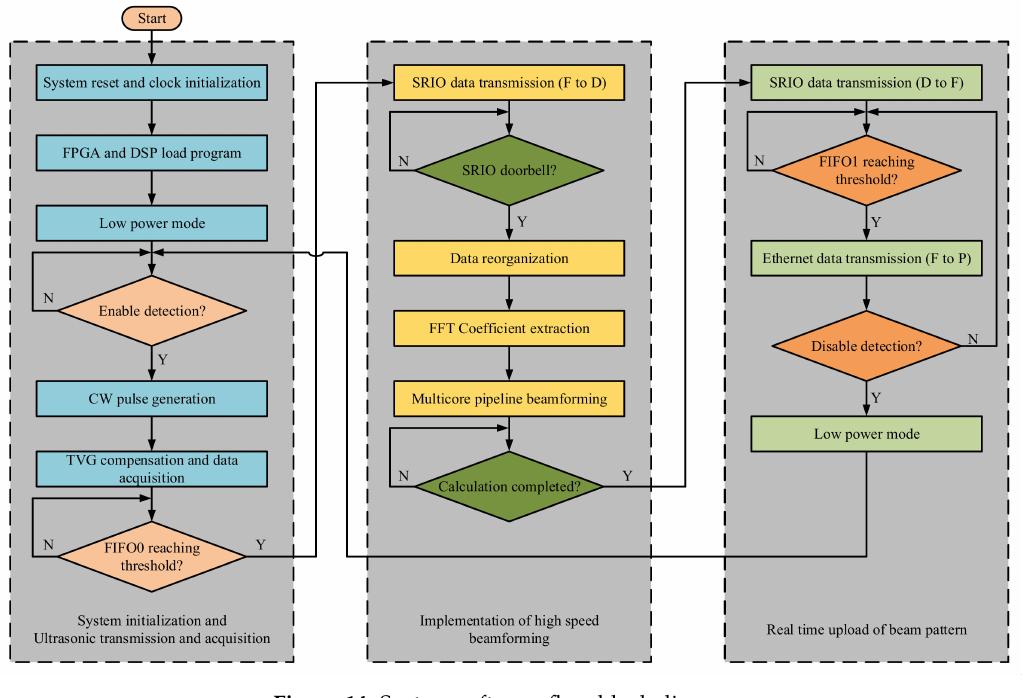
Figure 14. System software flow block diagram.